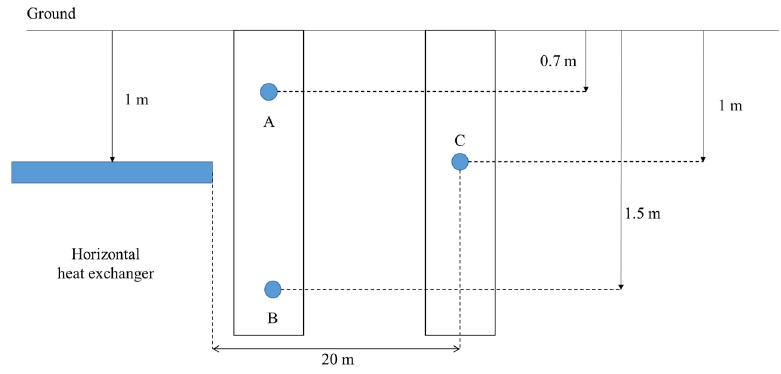
Figure 9. Vertical cross-section of sensors A, B, and C installation in Saraburi campus.